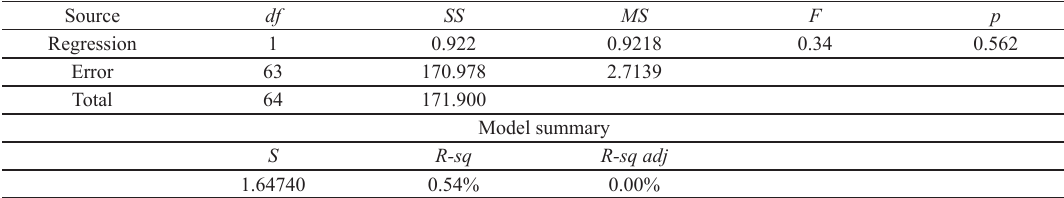
Table 9. Analysis of Variance: Tangential Tension Strength versus Density.